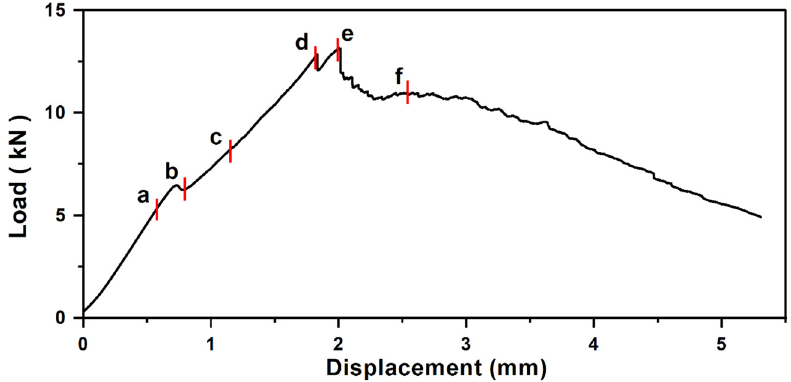
Figure 2: Typical load – displacement curves for di ff erent load